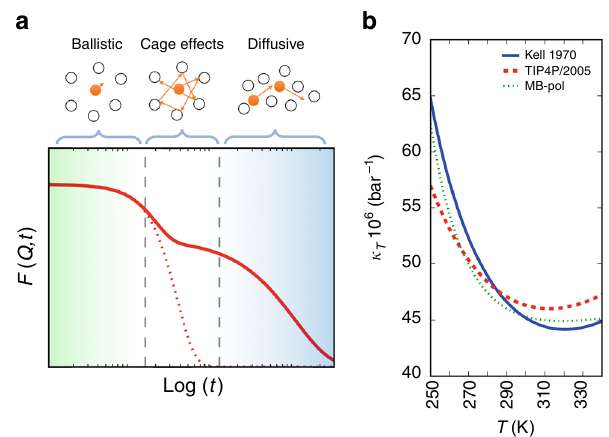
Fig. 6 A schematic representation of the different regimes of water dynamics. a The intermediate scattering function F ( Q,t ) is depicted as a function of the logarithm of time. The curves correspond to the experiment (solid), and the pure ballistic case (dotted). The vertical lines highlight the three different regimes: the early ballistic thermal-like motion, the cage effect regime and the diffusive regime. The current experiment probes the timescales between the ballistic regime and the cage effects. b The isothermal compressibility exhibits similar trends as the observed dynamics, when comparing experiments 60 with simulations